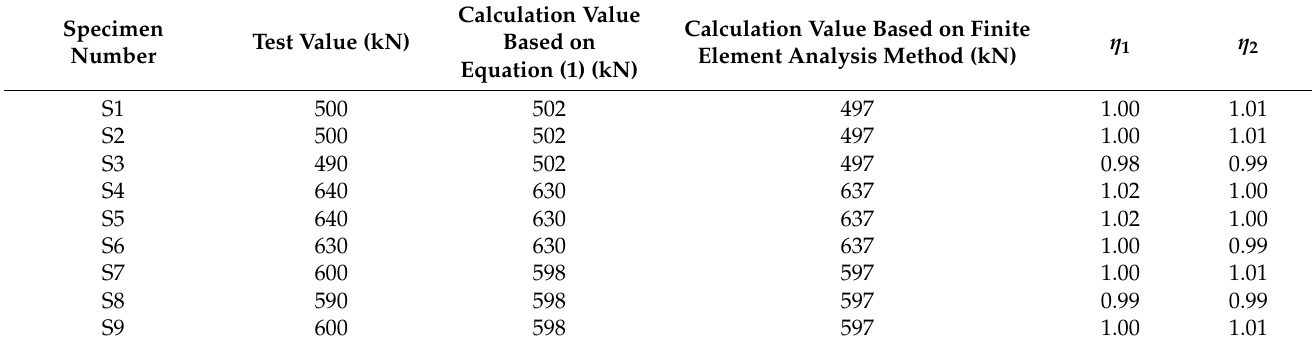
Table 6. The calculation value of the ultimate bearing capacity of the BRFC short column.